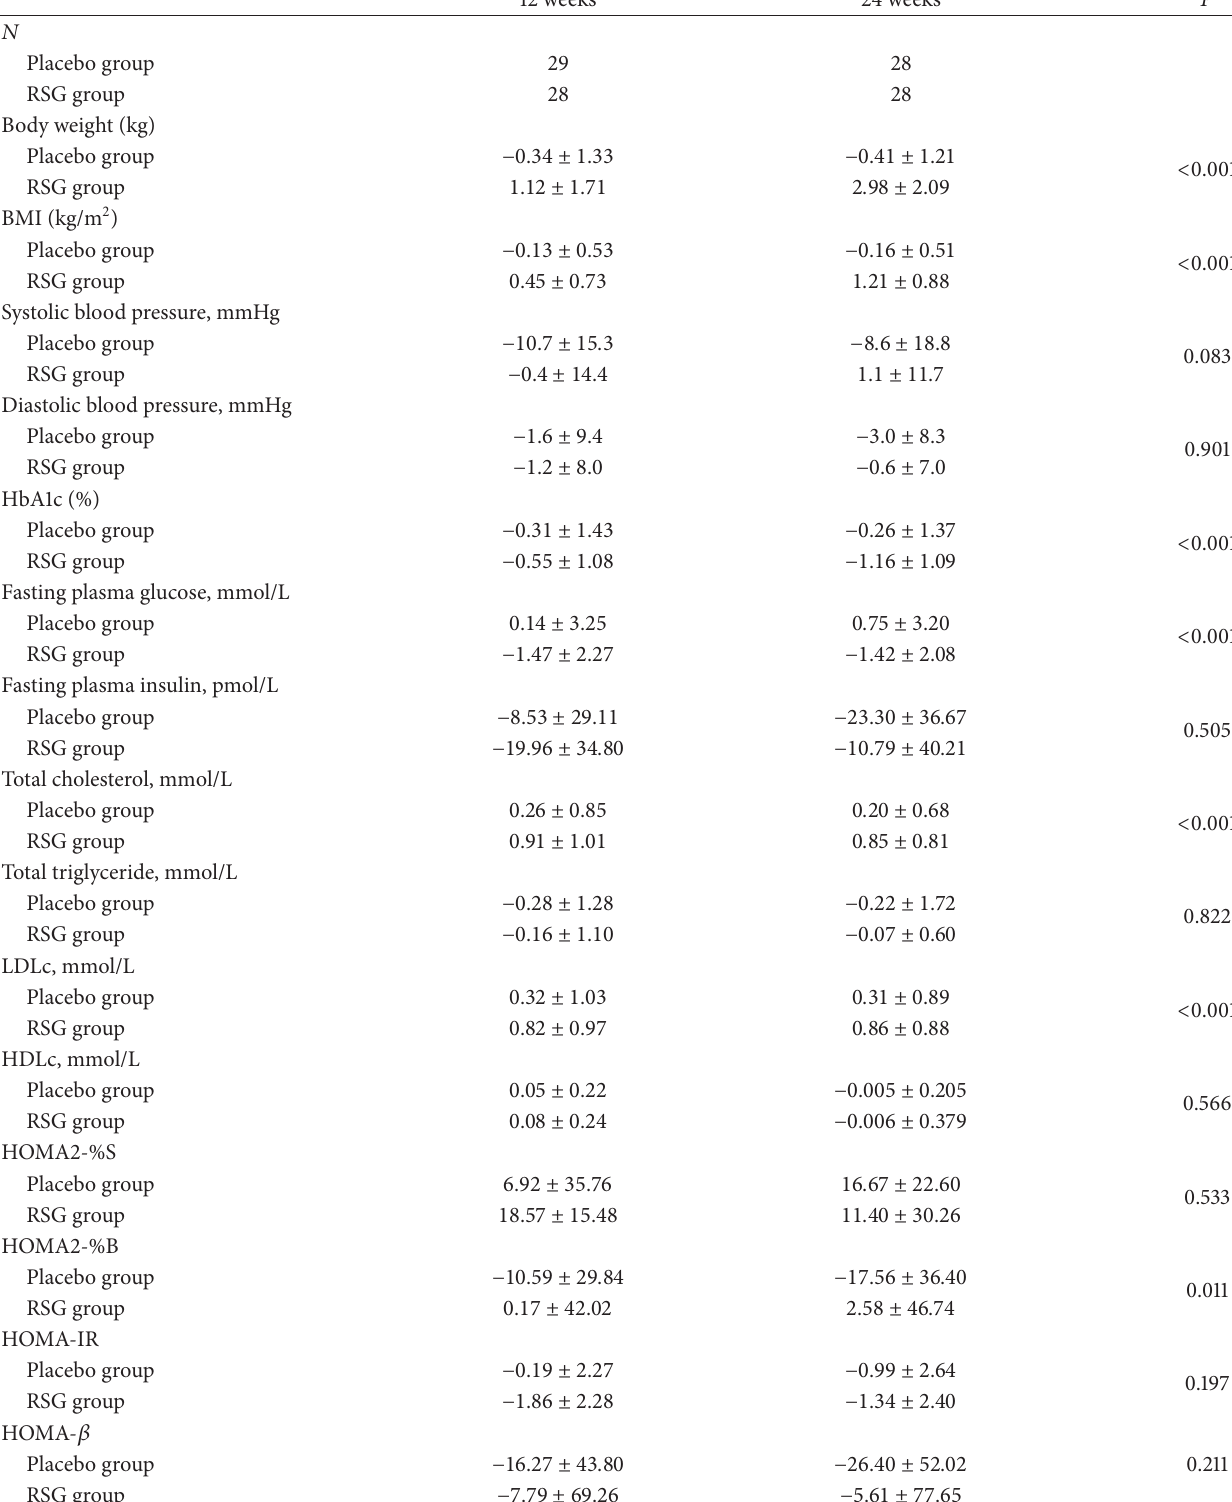
Table 2: Changes in metabolic parameters after 24 weeks of